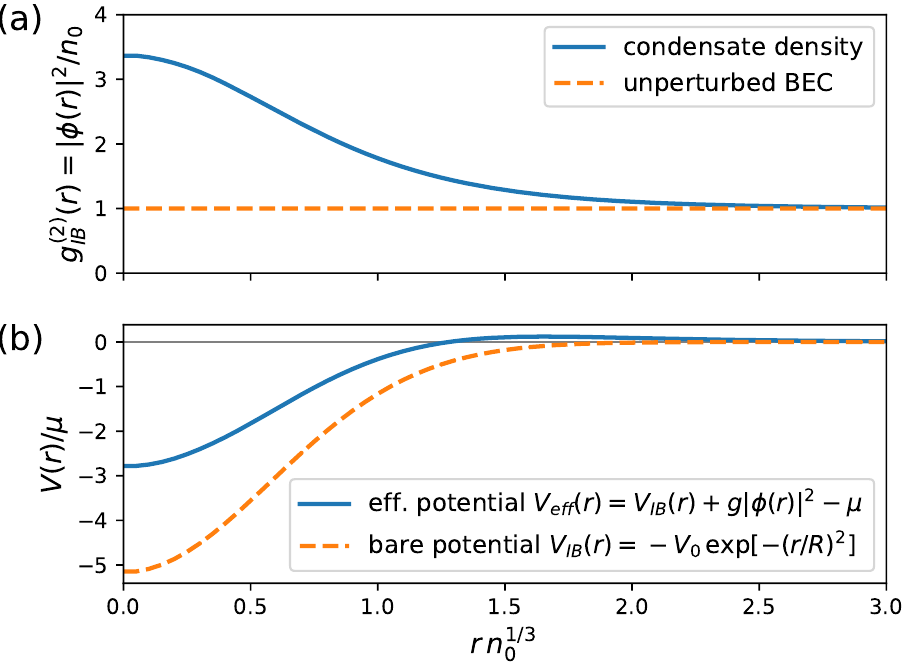
( 2 ) ( r ) as deter- IB (cid:112) ( r ) = n 0 0 = ξ and positive eff